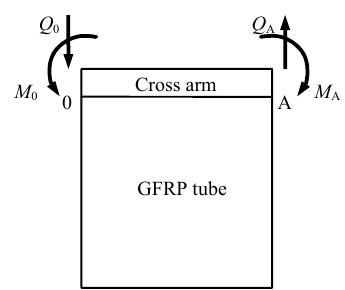
Figure 10. Schematic diagram of elastic foundation beam model.